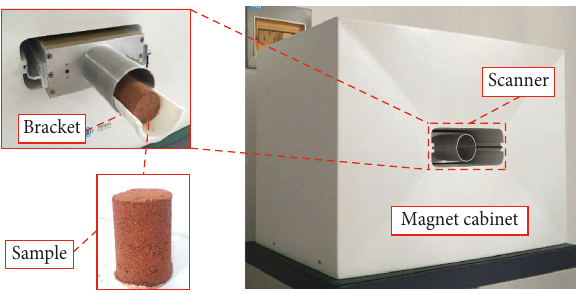
Figure 4: PQ-OO1-type mini-NMR spectrometer.